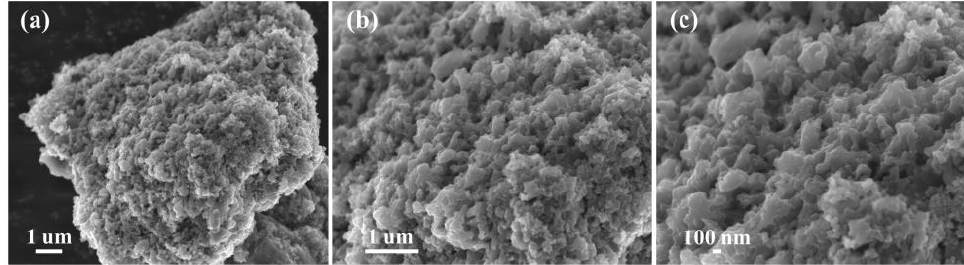
Figure 9. ( a – c ) SEM images of C OCLP-4.5 with different multiples after 5000 cycles.